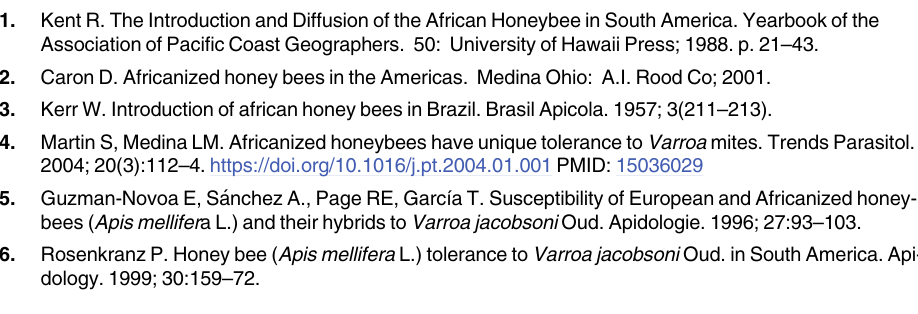
S5 Table. Pairwise Spearman rank correlations between seasonal weather (rainy season) and viral prevalence in adults (A) and larvae (L). Significant correlations (p < 0.05) are repre- sented in bold case. Positive and negative correlations are highlighted in green and red, respec-